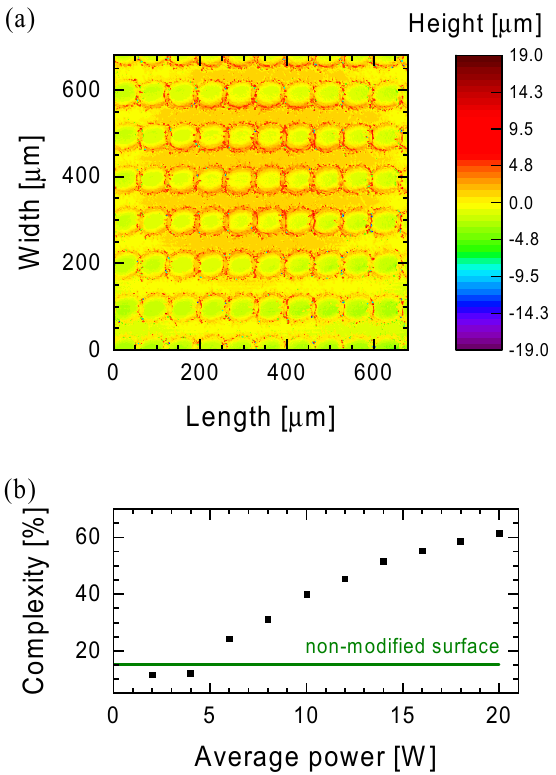
Figure 2. An example of a 2D map of craters on the surface of the Ti6Al4V alloy after the functionalization process at an average laser power of 12 W obtained by measurements with a confocal microscope at ×20 magnification ( a ). The results of the complexity estimation as a function of the average laser power used in the process of surface functionalization of the Ti6Al4V alloy ( b ). The functionalization process was carried out at a frequency of 35 kHz, a hatch distance of 100 µm and a scanning speed of 2400 mm/s. The green arrow in the graph ( b ) denotes the value for non-modified surface of the alloy.